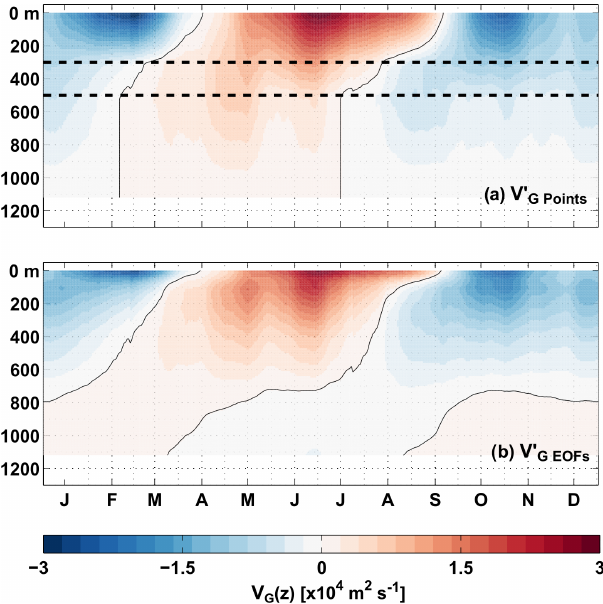
Figure 11. Mean seasonal cycle of the geostrophic transport per unit depth, V (cid:48) , over the period 2013–2018, derived from observations at G 11 ◦ S with two methods: (a) piecewise linear interpolation between the four supporting points at 0, 300, 500 and 1130m depth (dashed black lines mark the depths of the BPRs). (b) Reconstruction of V (cid:48) by regression of the dominant vertical structure functions from the INALT01 model onto the values at the three depth levels of pressure observations at 0, 300 and 500m depth, thereby relaxing the no- flow condition at 1130m depth. Red (blue) colours show northward (southward)